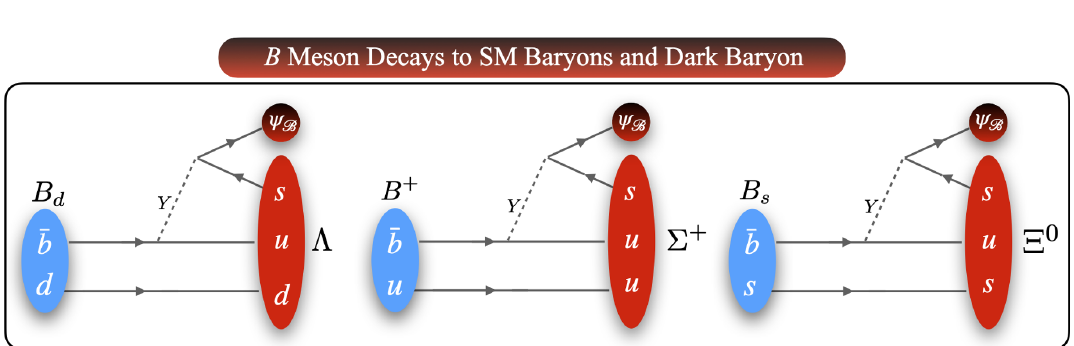
Figure 1 . Decay modes of B 0 and B + mesons through the O b,us and O s,ub operators. Decays s,d through the other operators listed in table 1 arise in a similar